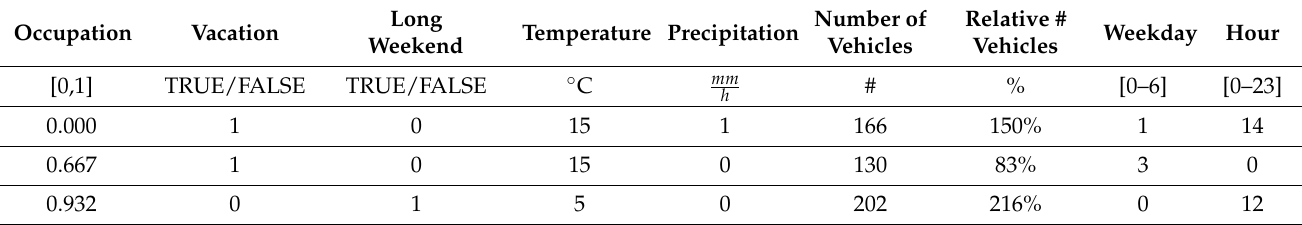
Table 2. Example of the merged